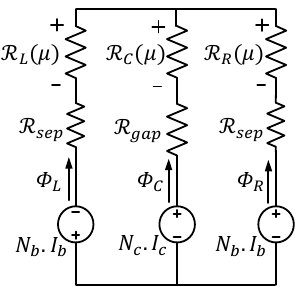
Figure 2. Reluctance equivalent circuit of the double E-core variable inductor shown in Figure